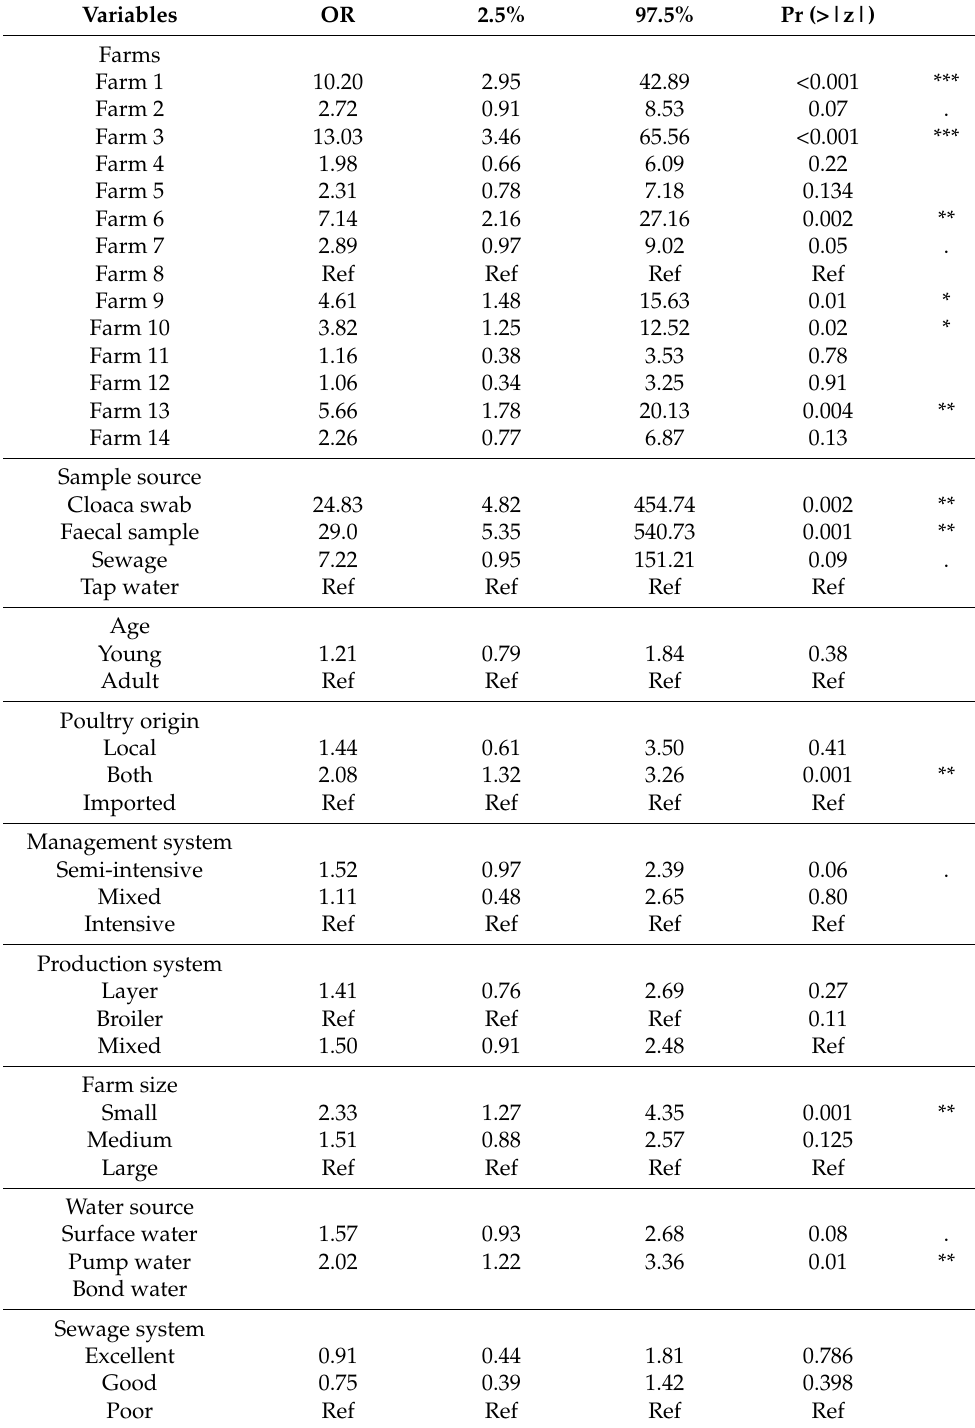
Table 4. Univariate regression analysis of risk factors for antimicrobial-resistant E. coli from poultry farms in east coast of Malaysia (n = 238